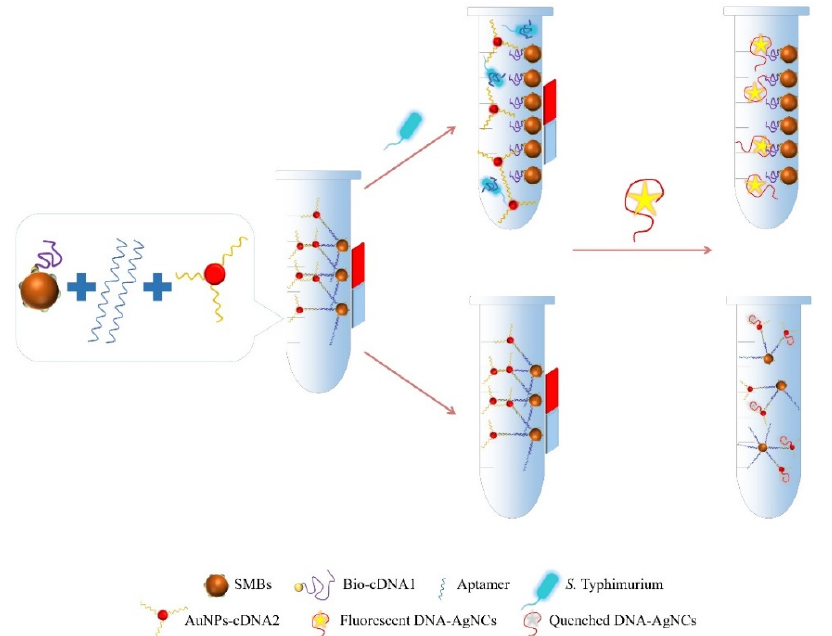
Scheme 1. Schematic diagram of the fluorescence aptasensor for testing of Salmonella Typhimurium by magnetic beads/gold nanoparticles/DNA-stabilized silver nanoclusters.